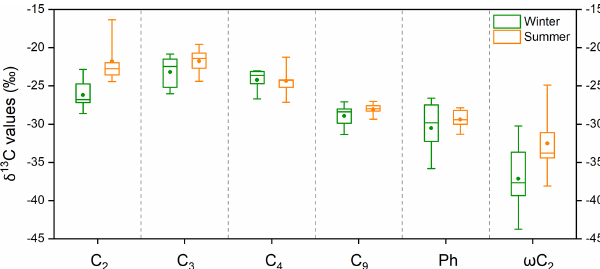
Figure 4. Box-and-whisker plot of the δ 13 C values for four sat- urated aliphatic dicarboxylic acids (C 2 , C 3 , C 4 , and C 9 ), phthalic acid (Ph), and glyoxylic acid ( ω C 2 ) in PM 2 . 5 collected in five Chi- nese megacities in January 2018 (winter) and July 2018 (summer). Each box indicates the median (the line within the box), the mean (the solid dot within the box), the interquartile range (the ends of the box), and the 10th and 90th percentiles (the